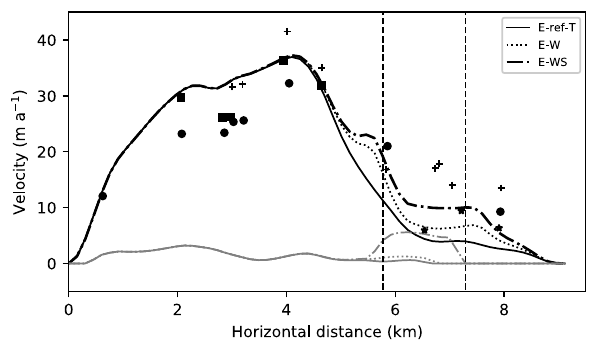
Figure 10. Modelled surface (black lines) and basal (gray lines) horizontal velocities along the CL for experiments E-ref-T (solid line), E-W (dotted line), and E-WS (dash-dotted line). The glacier widths in the zone of 5.8–7.3km (bounded by the vertical dashed lines) are increased by 450m for E-W and E-WS. In E-WS, we also include a basal sliding enhancement between 5.8 and